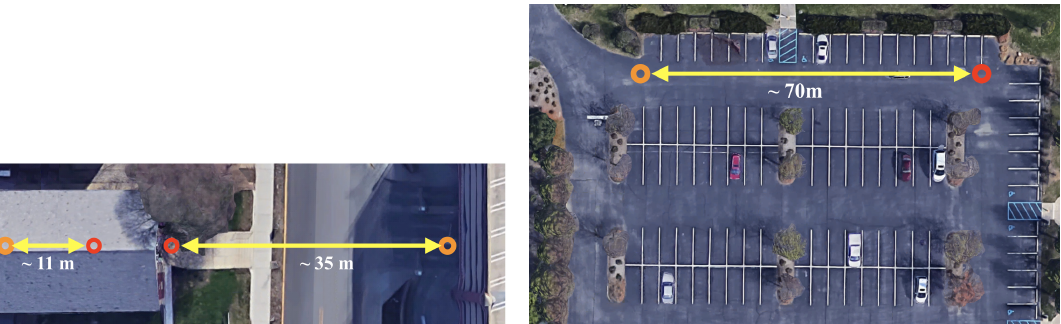
Figure 10. Indoor (left arrow) and outdoor short distant (right arrow) experiment setup ( left ); outdoor experiment set-up ( right